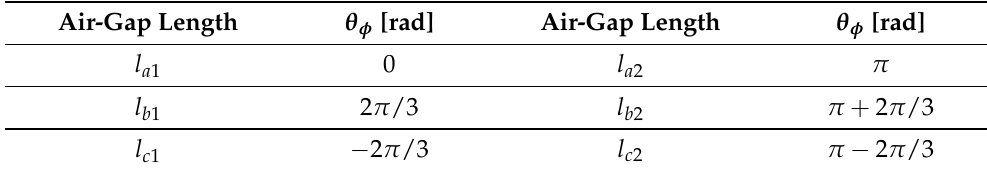
Table 2. Phase equivalent air-gap length